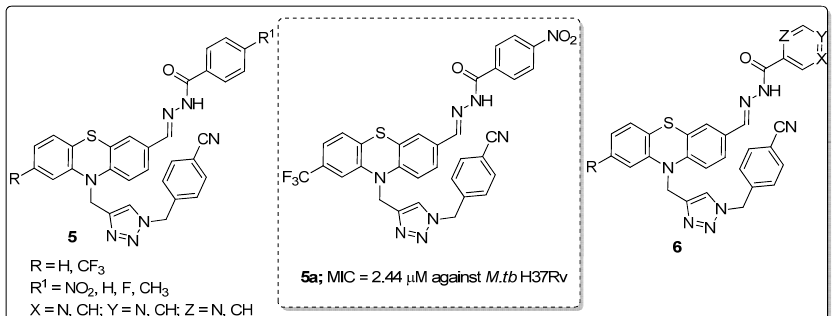
Figure 8. Most significant antitubercular activity phenothiazine-1,2,3-triazole conjugate 5a .